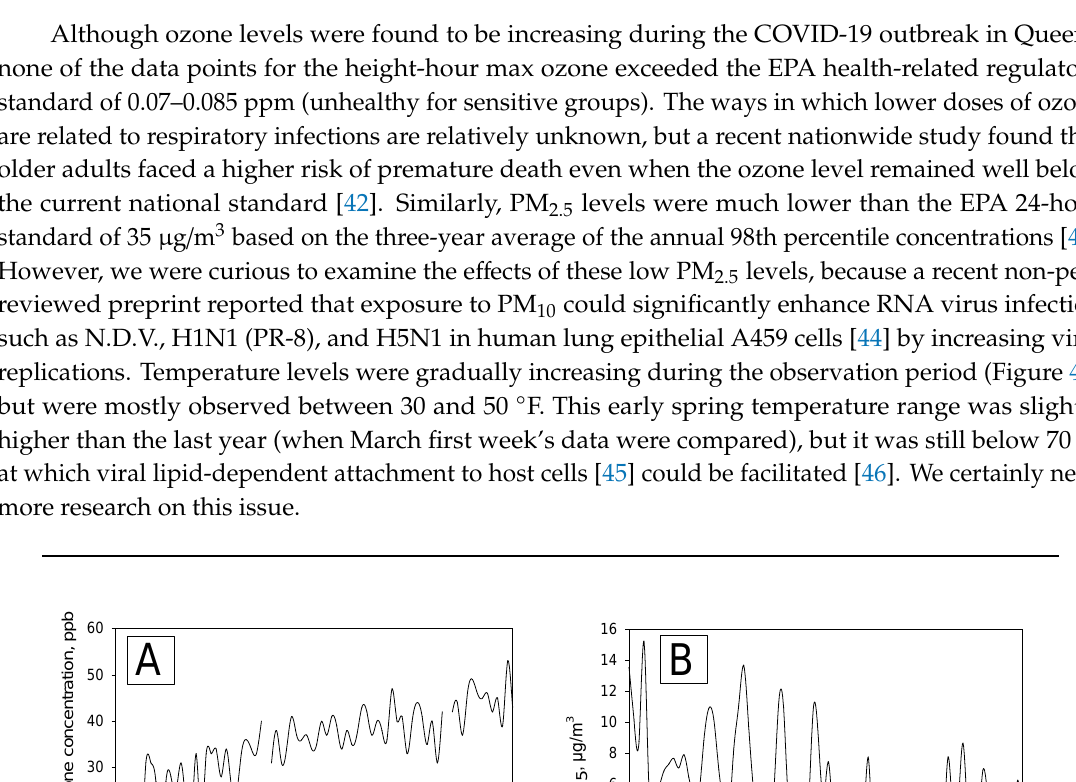
Table 1. Descriptive statistics of PM 2.5 , ozone, and meteorological variables across all days.